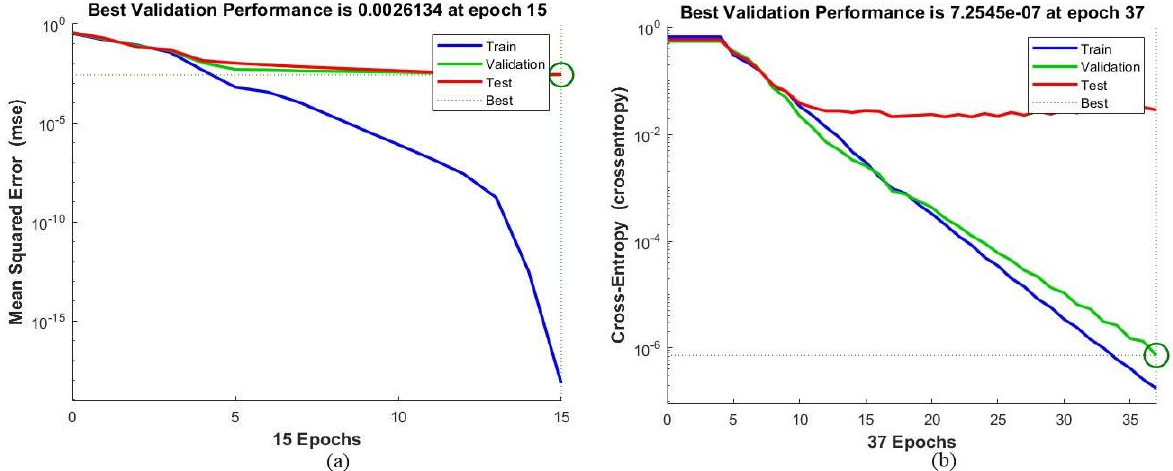
Figure 11. Performance designs of the ASD dataset: ( a ) FFNN algorithm and ( b ) ANN algorithm.